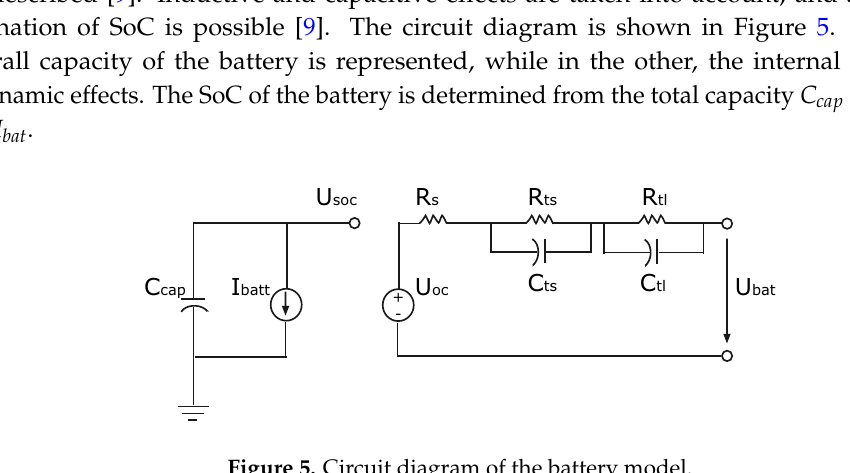
Figure 5. Circuit diagram of the battery